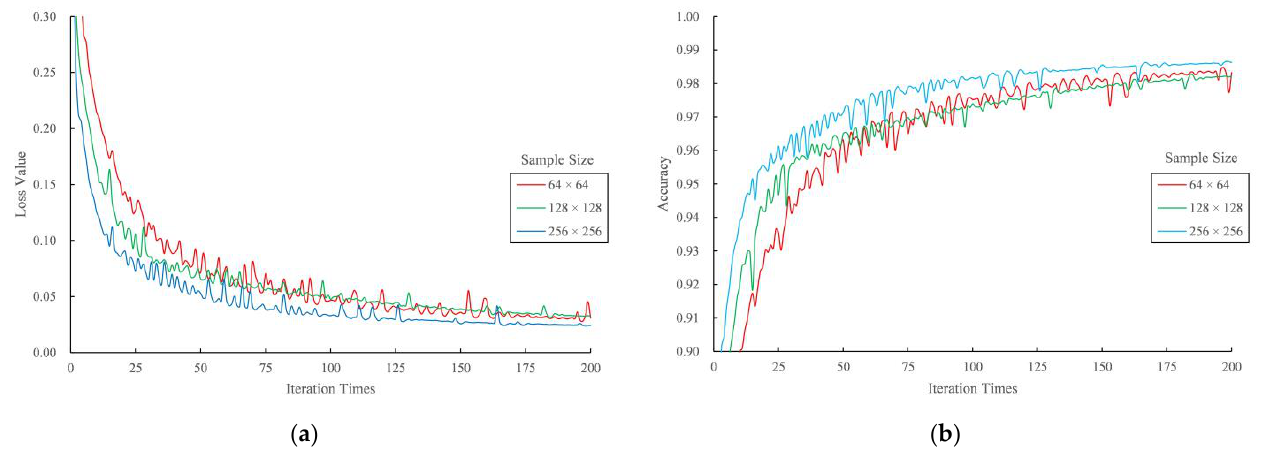
Figure 5. The change curve of training loss value with the iterations times ( a ) and the change curve of training accuracy with the iterations times ( b ) under different sample sizes.